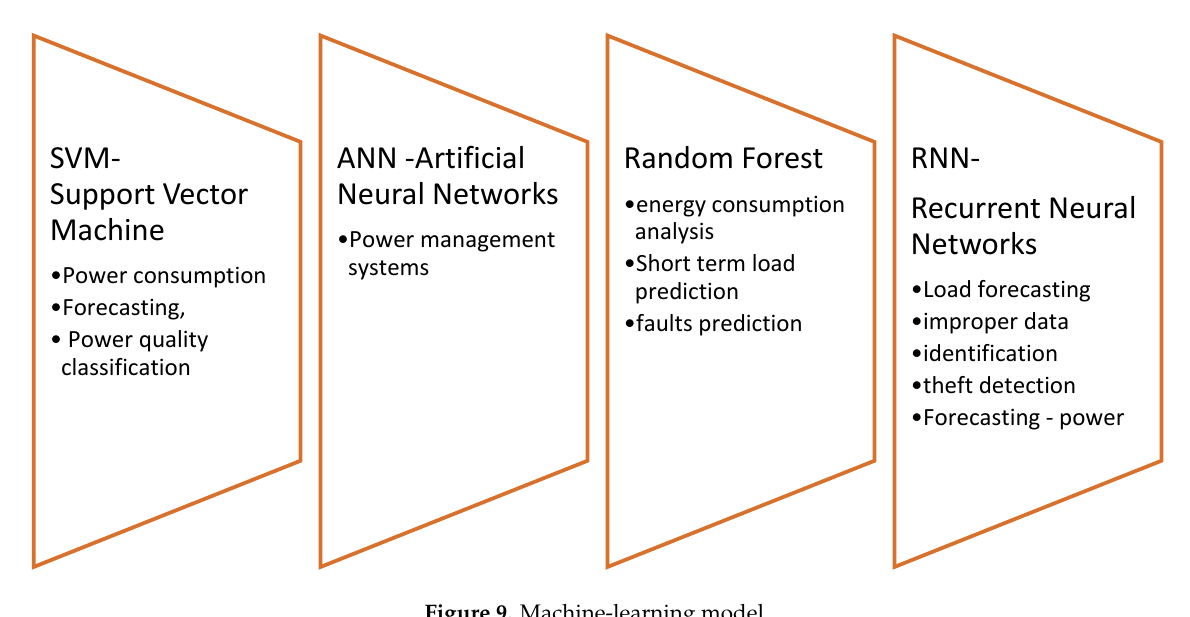
Figure 9. Machine-learning model.